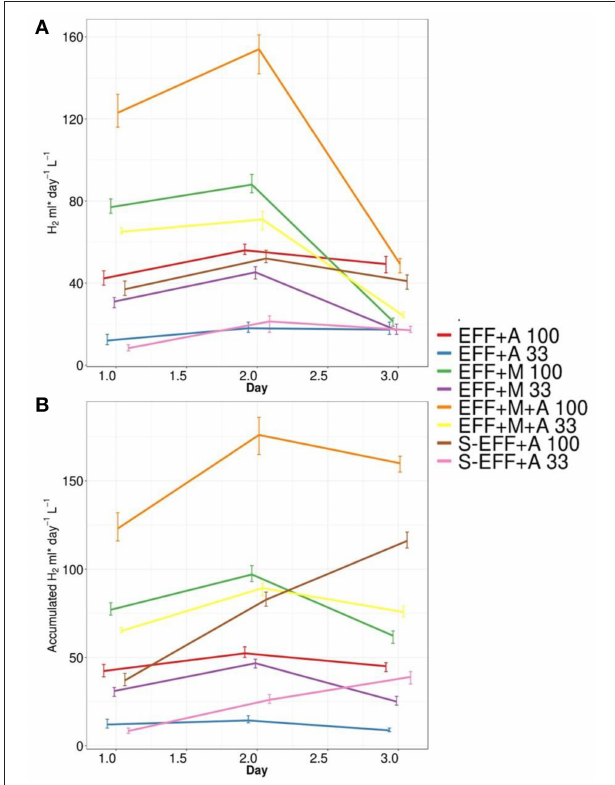
FIGURE 2 | Daily (A) and cumulative biohydrogen production (B) in the photoheterotrophic stage. Microalgae inoculum was added to the effluent resulted from a dark-fermentative biohydrogen production process. Photoheterotrophic biohydrogen production experiments were performed using different experimental conditions according to Table 1 . Each of these different experimental conditions were investigated using diluted and non-diluted dark fermentation